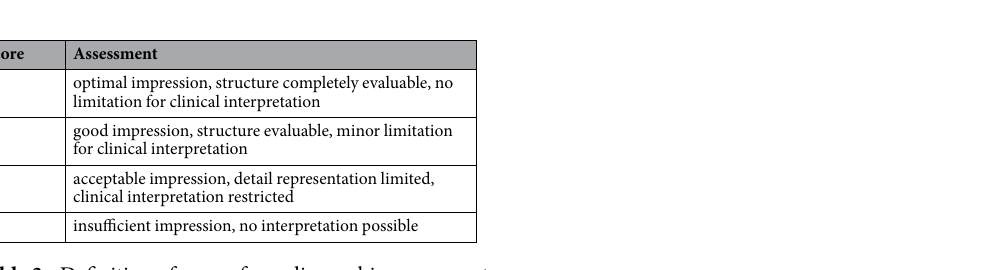
Table 3. Definition of scores for radiographic